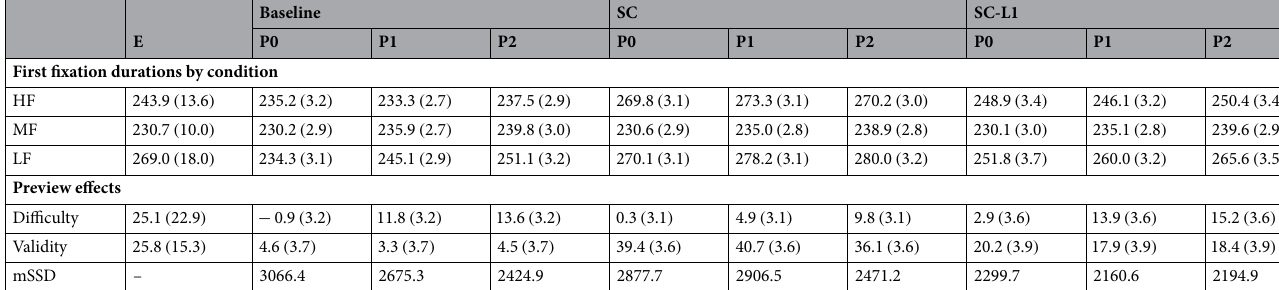
Table 1. Mean first fixation durations on word n + 1 and preview effect sizes in the experiment and model simulations, with 95% confidence intervals in parentheses. CIs are smaller in simulations due to the increased data volume. The models were scored using the mean sum of squared deviations (mSSD) of simulated preview effects from experimental results per participant.